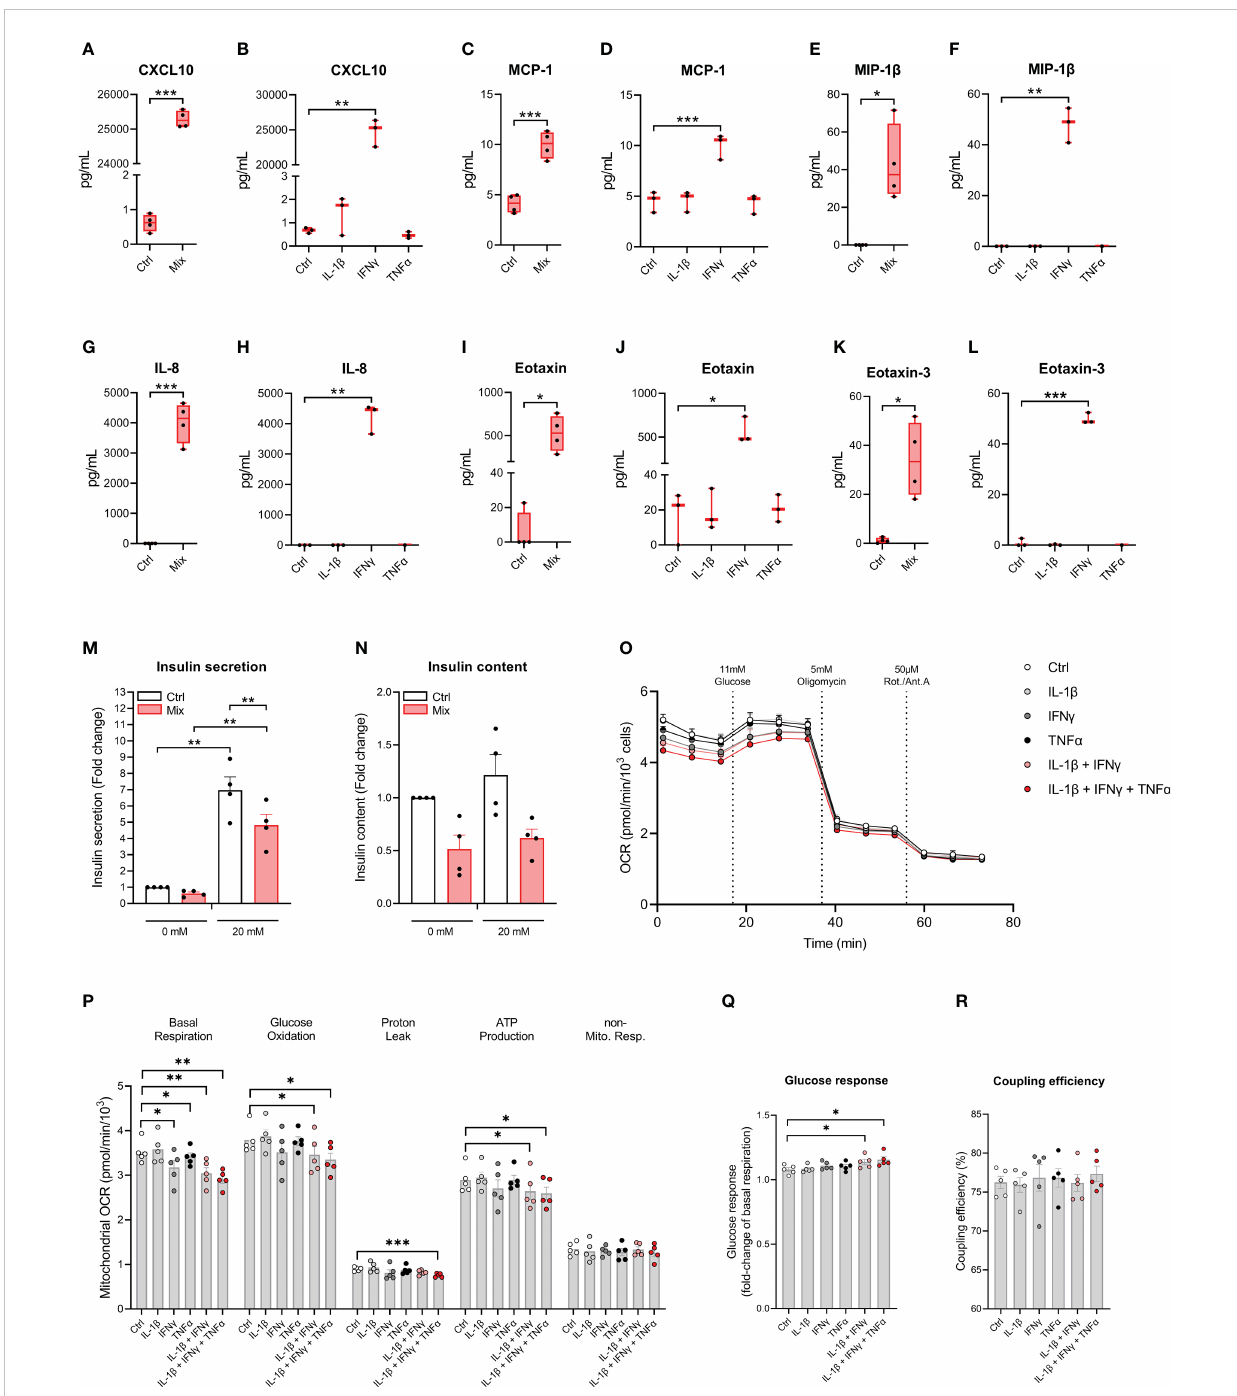
FIGURE 4 Cytokine-induced secretory and functional changes in the EndoC- b H5 cells. Accumulated chemokines in the culture medium from EndoC- b H5 cells after 48 h of cytokine treatment (50 U/mL IL-1 b , 1000 U/mL IFN g and 1000 U/mL TNF a ) in combination (Mix) or as individual cytokines, respectively: (A, B) IP-10/CXCL10, (C, D) MCP-1/CCL2, (E, F) MIP-1 b /CCL3, (G, H) IL-8/CXCL8, (I, J) Eotaxin/CCL11 and (K, L) Eotaxin-3/CCL26. Data are mean pg/mL with median and 5/95 percentiles (n=3-4). (M) Glucose-stimulated insulin secretion and (N) insulin content after 48 h of cytokine treatment (50 U/mL IL-1 b , 1000 U/mL IFN g and 1000 U/mL TNF a ) (Mix) in response to 0 mM or 20 mM glucose stimulation. Data was normalized to DNA content. Data are means ± SEM (n=4). Mitochondrial respiration in untreated cells and cells exposed to cytokines (50 U/mL IL-1 b , 1000 U/mL IFN g and 1000 U/mL TNF a ) alone or in combinations, as indicated, for 48 h. (O) oxygen consumption rate (OCR) traces normalized to cell number per well. (P) Analysis of mitochondrial parameters from OCR traces, corrected for non-mitochondrial respiration. (Q) Glucose response of respiration as fold-change of basal mitochondrial respiration. (R) Coupling ef fi ciency calculated as the oligomycin-sensitive fraction of glucose-stimulated mitochondrial respiration. Results are means ± SEM (n=5), *p<0.05, **p<0.01, ***p<0.001. Ctrl, untreated